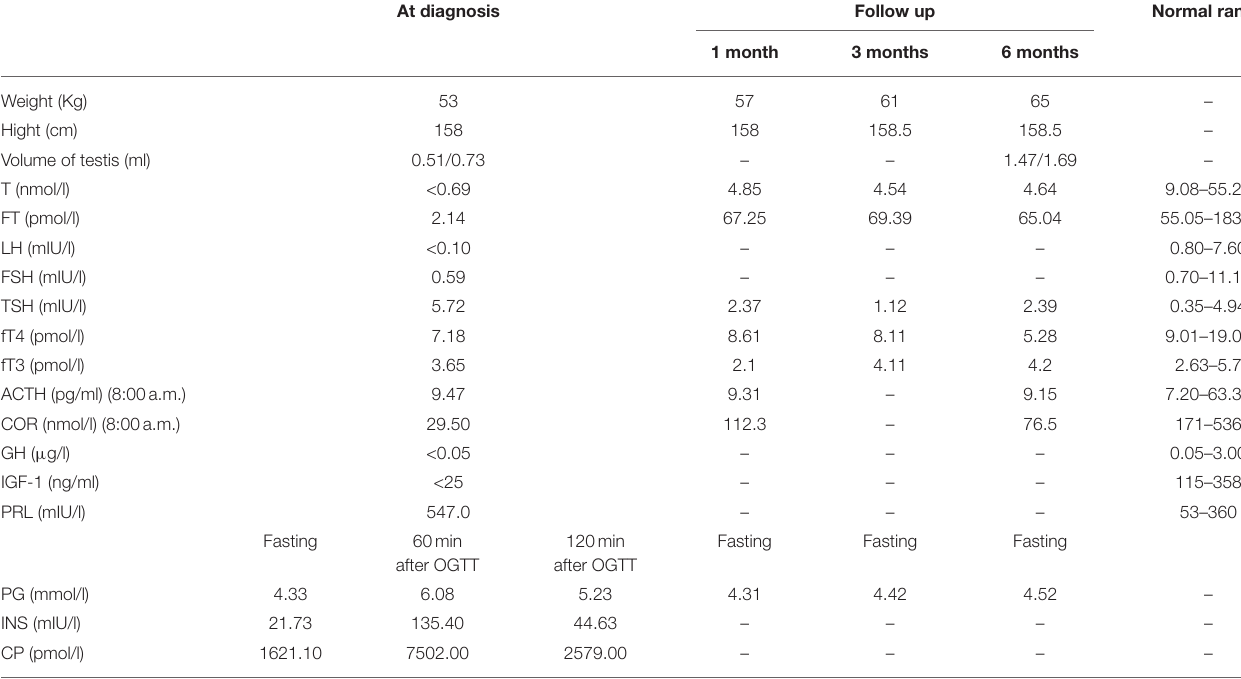
TABLE 1 | Clinical and laboratory data of the patient at diagnosis and follow up. At diagnosis Follow up Normal range